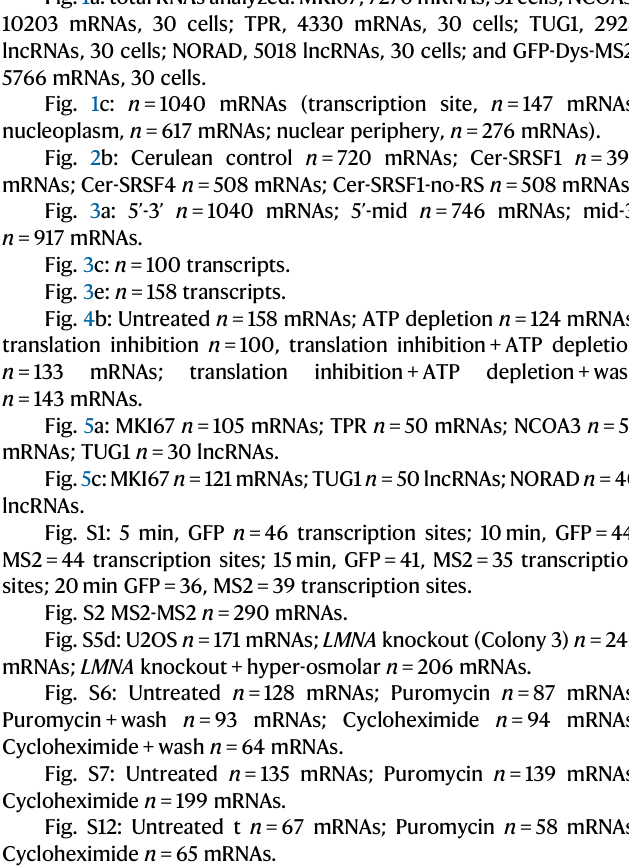
Fig. 1a: totalRNAs analyzed:MKI67, 7270 mRNAs,31 cells;NCOA3, 10203 mRNAs, 30 cells; TPR, 4330 mRNAs, 30 cells; TUG1, 2928 lncRNAs, 30 cells; NORAD, 5018 lncRNAs, 30 cells; and GFP-Dys-MS2, 5766 mRNAs, 30 cells. Fig. 1c: n =1040 mRNAs (transcription site, n =147 mRNAs; nucleoplasm, n = 617 mRNAs; nuclear periphery, n =276 mRNAs). Fig. 2b: Cerulean control n =720 mRNAs; Cer-SRSF1 n = 393 mRNAs; Cer-SRSF4 n = 508 mRNAs; Cer-SRSF1-no-RS n =508 mRNAs. Fig. 3a: 5 ’ -3 ’ n =1040 mRNAs; 5 ’ -mid n = 746 mRNAs; mid-3 ’ n = 917 mRNAs. Fig. 3c: n =100 transcripts. Fig. 3e: n =158 transcripts. Fig. 4b: Untreated n = 158 mRNAs; ATP depletion n =124 mRNAs; translation inhibition n =100, translation inhibition+ATP depletion n = 133 mRNAs; Fig. 5a: MKI67 n =105 mRNAs; TPR n = 50 mRNAs; NCOA3 n = 53 mRNAs; TUG1 n =30 lncRNAs. Fig.5c:MKI67 n = 121mRNAs;TUG1 n =50lncRNAs;NORAD n = 40 lncRNAs. Fig. S1: 5 min, GFP n =46 transcription sites; 10min, GFP=44, MS2 =44 transcription sites; 15min, GFP= 41, MS2 =35 transcription sites; 20min GFP=36, MS2= 39 transcription sites. Fig. S2 MS2-MS2 n =290 mRNAs. Fig. S5d: U2OS n =171 mRNAs; LMNA knockout (Colony 3) n = 246 mRNAs; LMNA knockout +hyper-osmolar n = 206 mRNAs. Fig. S6: Untreated n =128 mRNAs; Puromycin n =87 mRNAs; Puromycin +wash n = 93 mRNAs; Cycloheximide n = 94 mRNAs; Cycloheximide+ wash n =64 mRNAs. Fig. S7: Untreated n = 135 mRNAs; Puromycin n = 139 mRNAs; Cycloheximide n = 199 mRNAs. Fig. S12: Untreated t n =67 mRNAs; Puromycin n =58 mRNAs; Cycloheximide n = 65